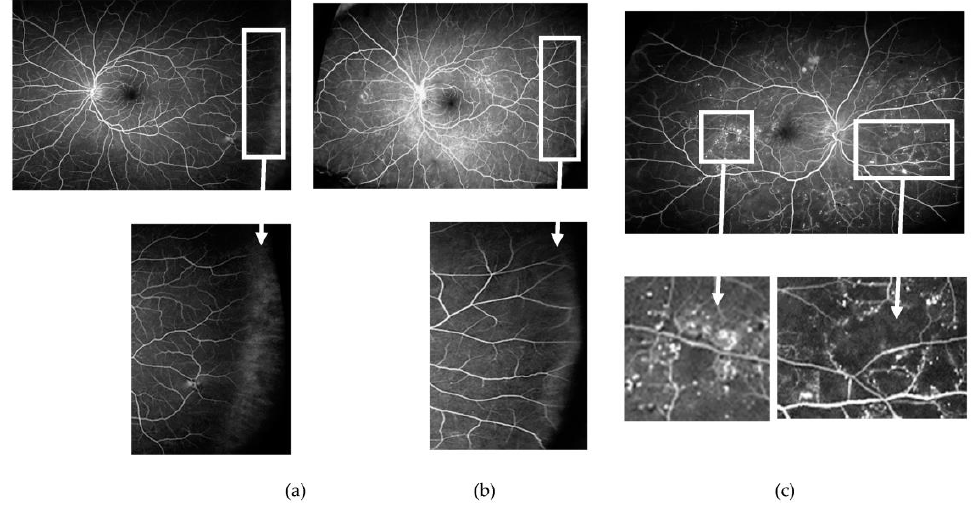
Figure 5. Venous phase of an ultrawide field fundus fluorescein angiogram obtained from three patients with non-proliferative diabetic retinopathy. Note in (( a ) and corresponding inset) the lack of perfusion of the far peripheral temporal retina when compared with (( b ) and corresponding inset) where blood vessels reached the far periphery. Interindividual differences with regard to the extension of the retinal vessels to the far peripheral retina may affect measures of retinal ischaemia if these areas of “nonperfusion” are considered “ischaemic”. In contrast, areas of ischaemia at other locations are usually well delineated and easier to identify, often surrounded by areas with multiple microaneurysms and microvascular changes (( c ) and corresponding inset).